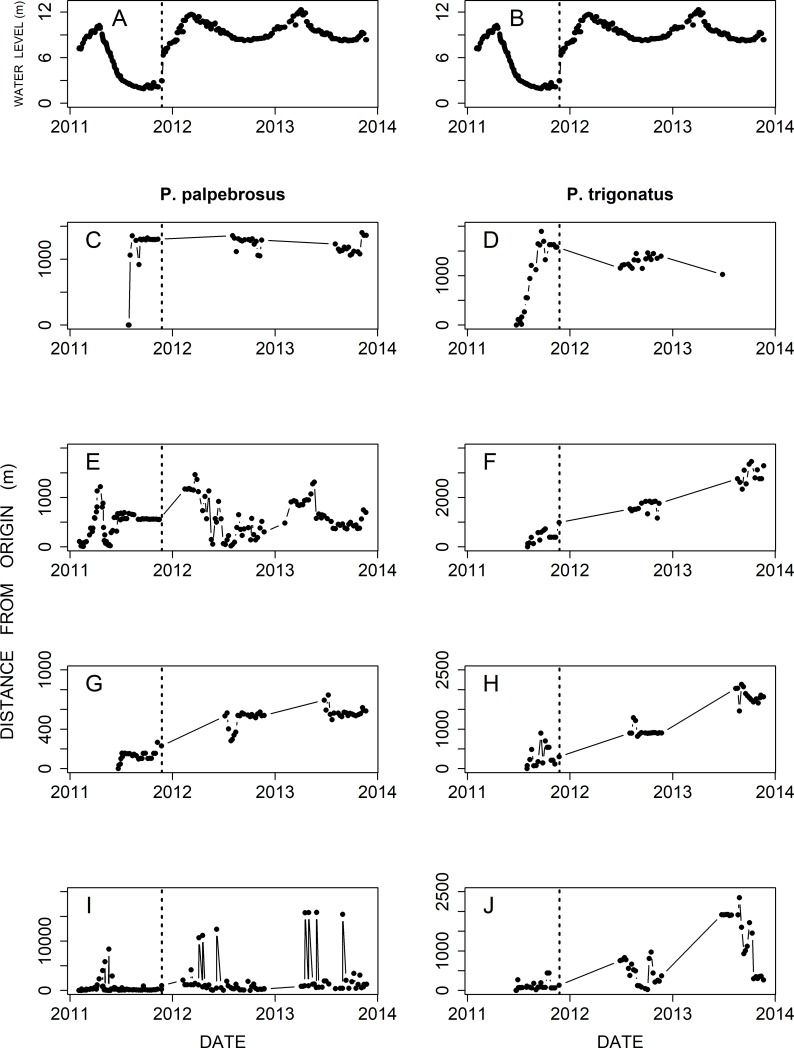
Water-level variation of the Jaci River, tributary of the Madeira River, in the reservoir area of the Santo Antônio Dam (upper graphs).Distances moved from the point of origin by four Paleosuchus palpebrosus and four Paleosuchus trigonatus at different times during the study. The dam was filled in November 2011.